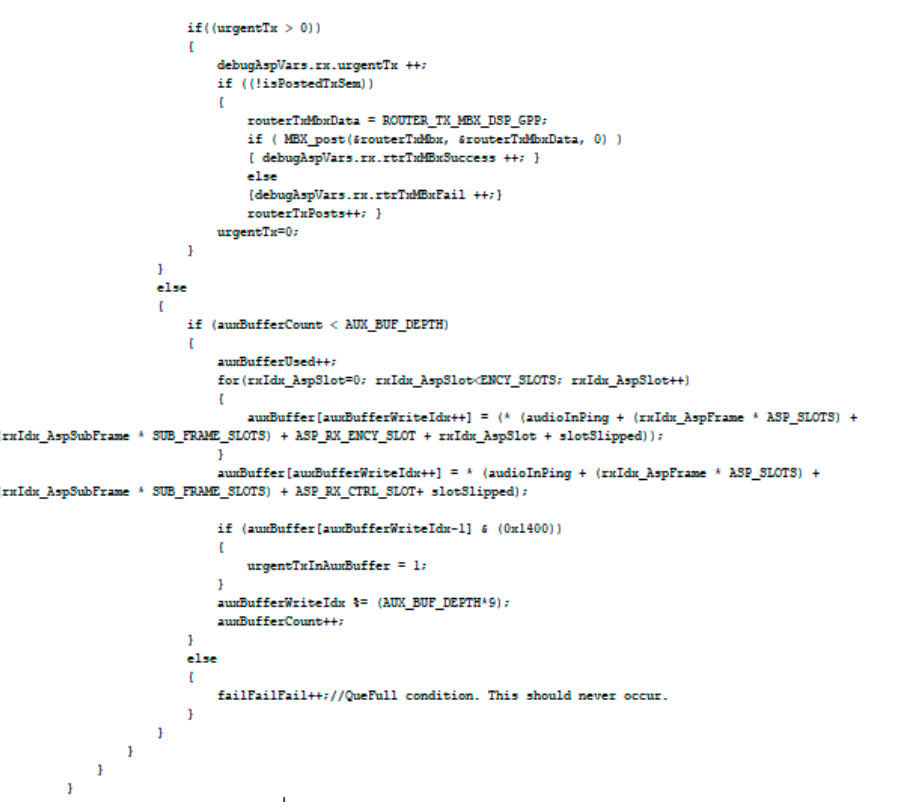
Figure 20. Code used whenever data are received via serial port.